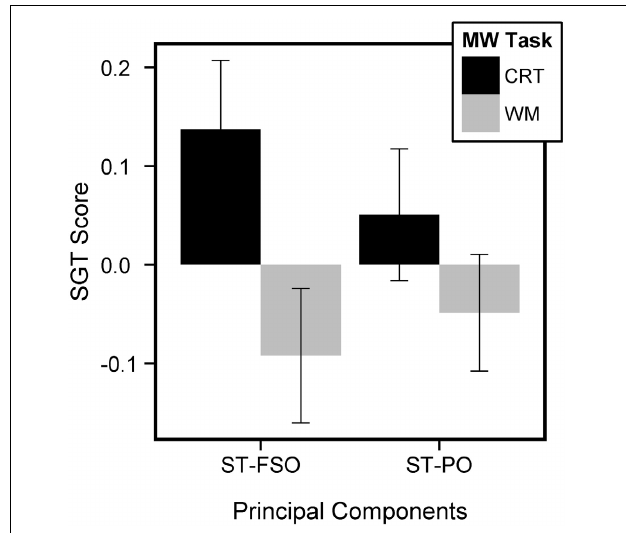
FIGURE 3 | Mean SGT Scores across subjects for each Principal component and each task. SGT scores were higher in the CRT than the WM task.